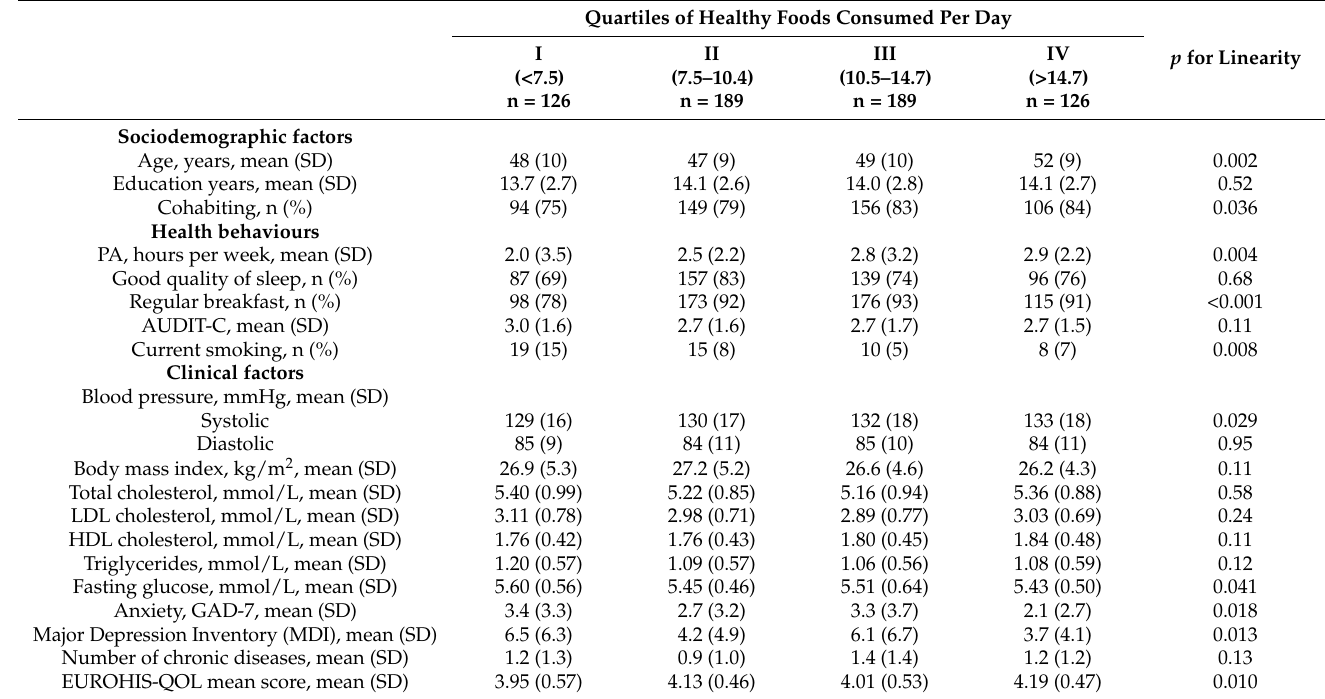
Table 2. Characteristics of the participants according to the quartiles of the consumption frequencies of healthy foods.